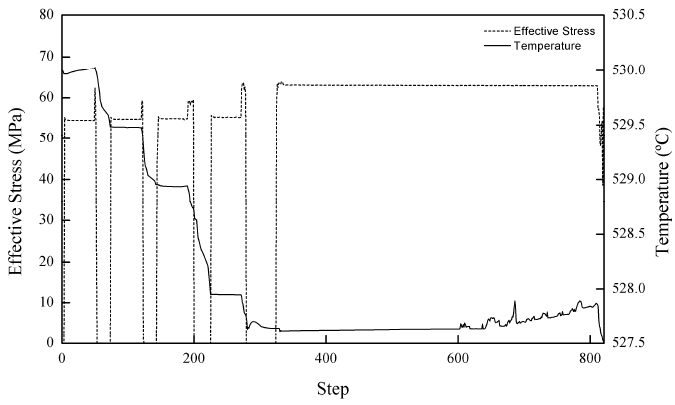
Figure 10. Stress and temperature interaction during the HPF process.